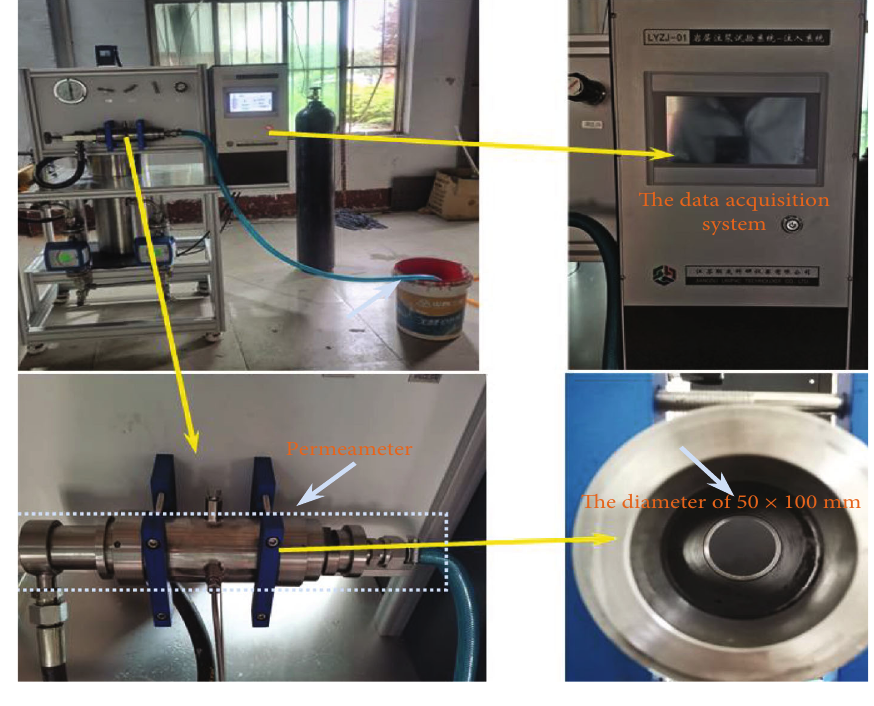
Figure 1: Permeability test system for broken rock mass.